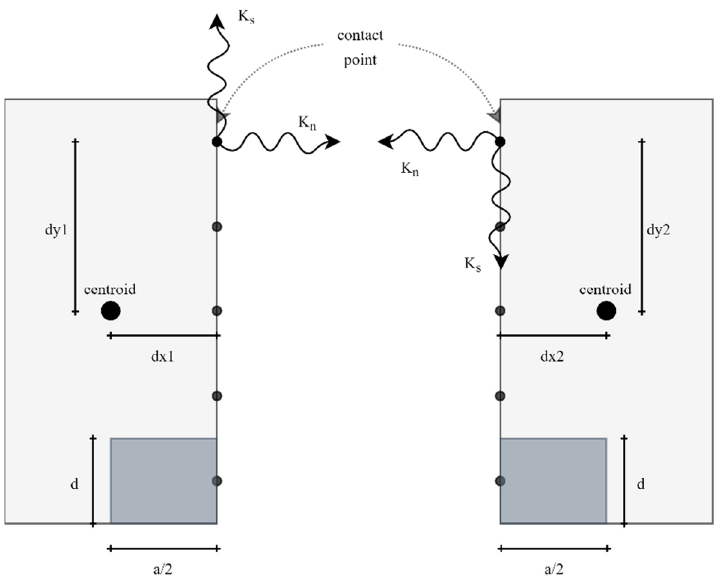
Figure 1. Contact points, spring distribution, normal and shear stiffness connecting two elements.